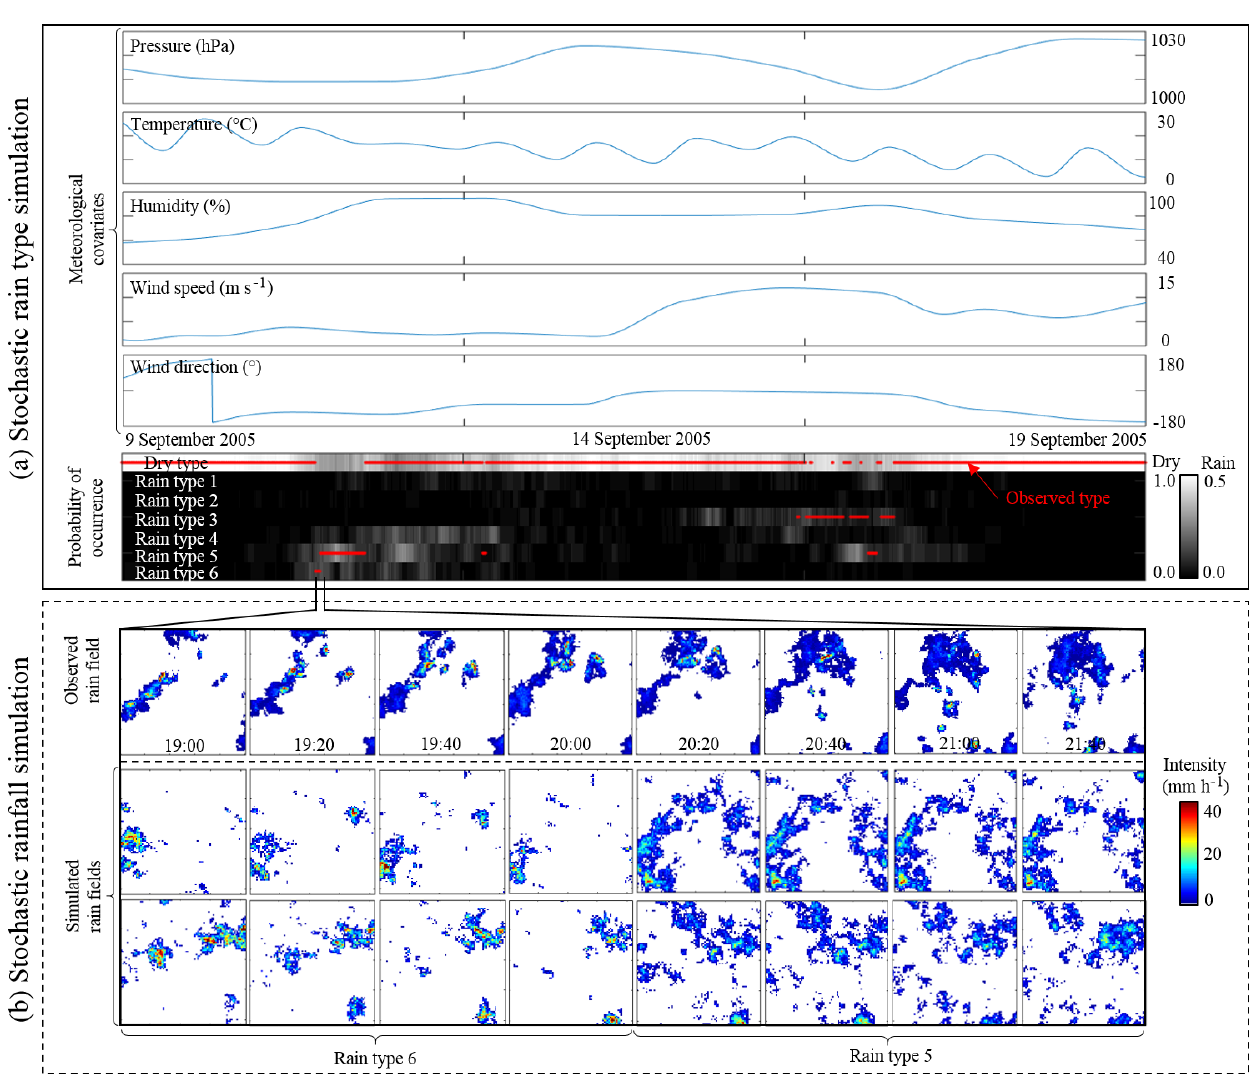
Figure 1. Overview of stochastic rain type generation (core of this study) and its application to simulate high-resolution synthetic rain fields whose statistical properties depend on meteorological conditions. (a) Rain type simulation framework developed in this study. (b) Illustration of stochastic rainfall simulation conditioned to changing rain types. In the bottom row of (a) , the observed rain types are in red, and the gray-shaded background denotes the probability of rain type occurrence derived from stochastic rain type simulations conditioned to the meteorological covariates displayed in the four top lines. In (b) , the upper row displays actual rain fields observed by radar imagery, and the two bottom rows display two stochastic simulations of synthetic rain fields for the same period generated using the approach of Benoit et al.